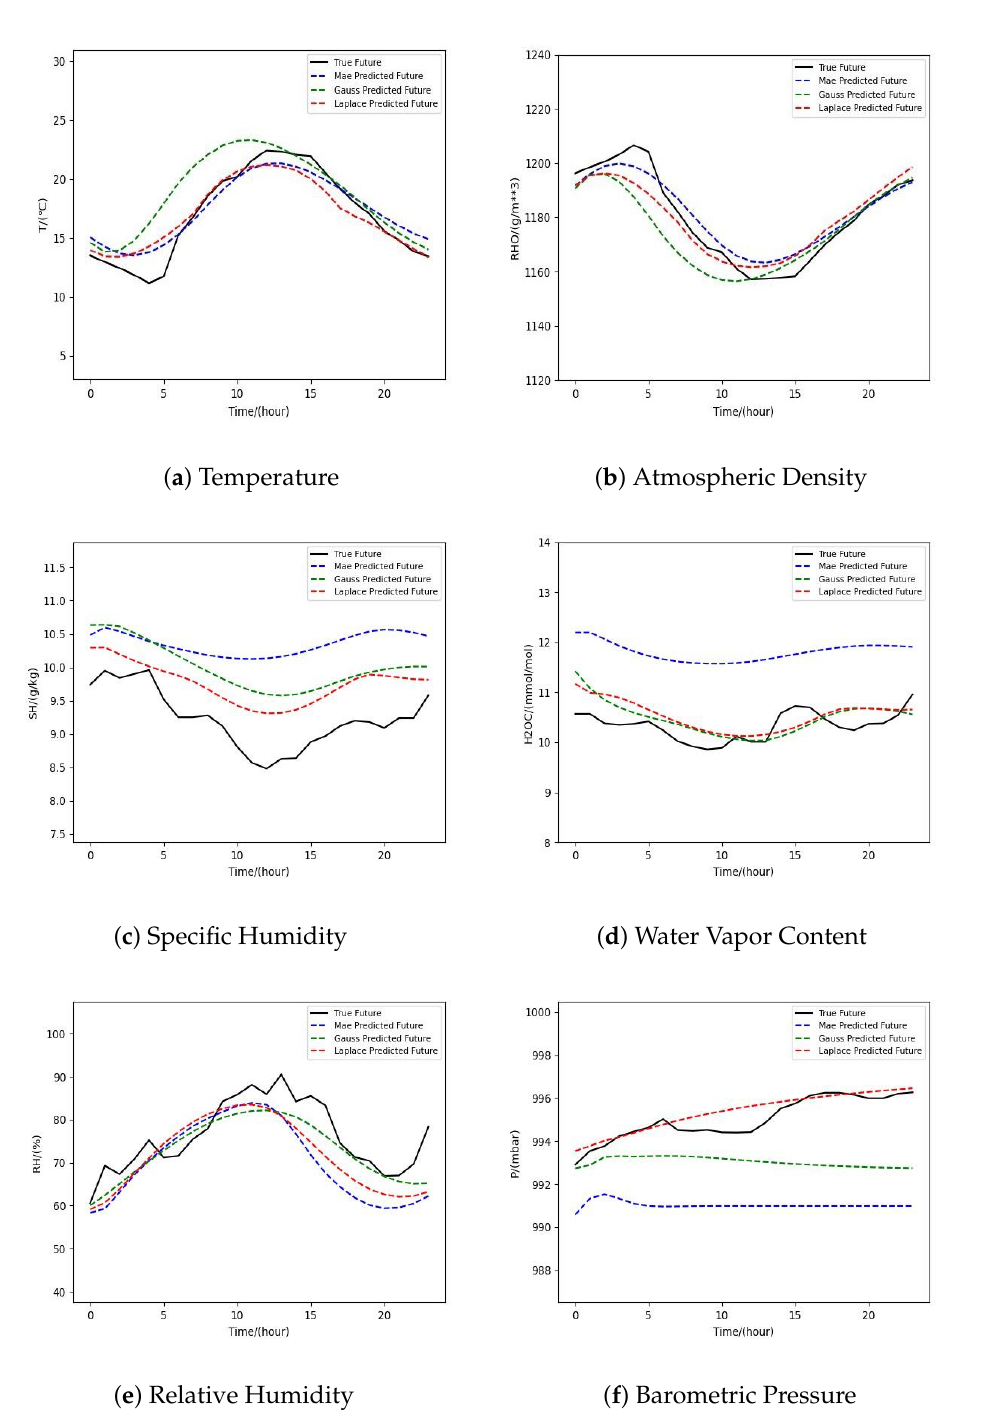
Figure 8. Prediction results of Model (cid:175) (cid:176) (cid:177) for meteorological parameters. The black curve is the observed value, and the red, green, and blue lines represent the predicted value when the multitask model uses different loss functions. Among all the results, the model based on Laplace multitask loss function achieved the best prediction